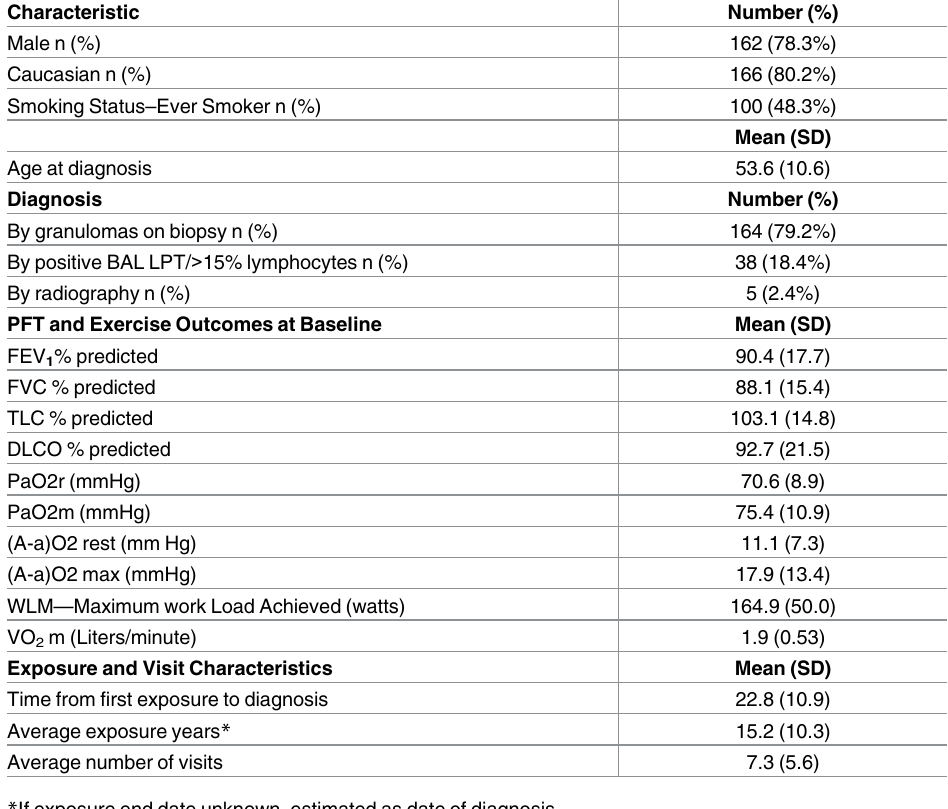
Table 1. CBD patient population demographics and clinical results (N =